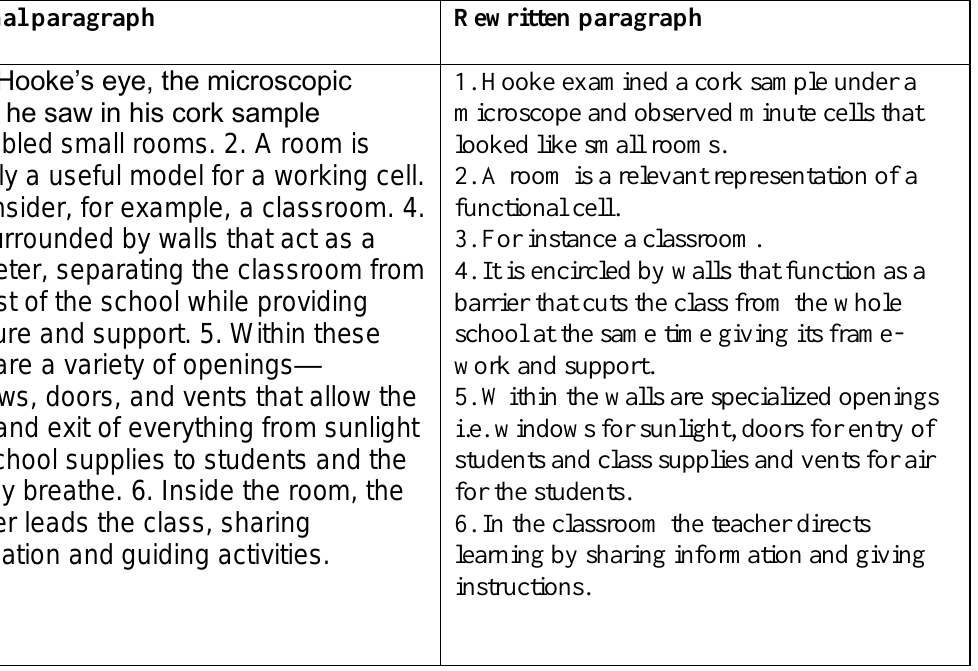
Figure 3 : Example of reconstructed